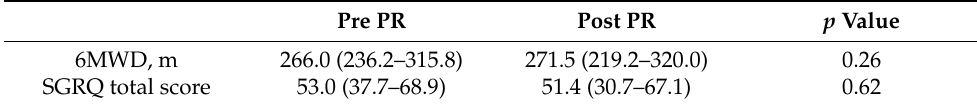
Table 3. Changes in 6MWD and SGRQ total